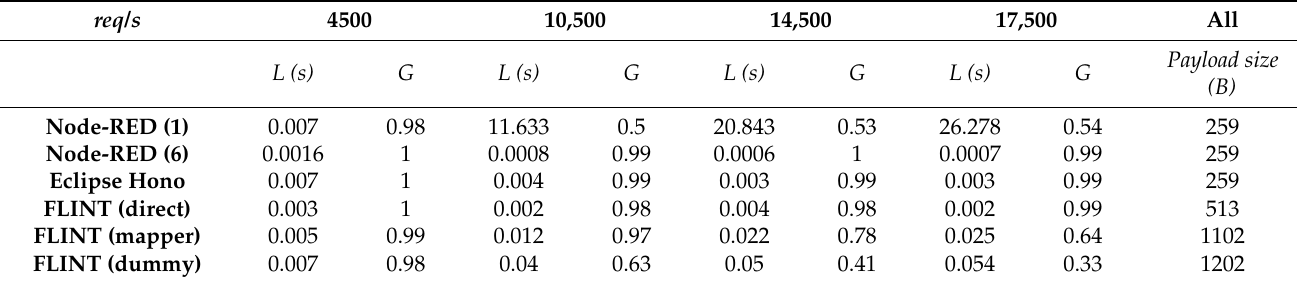
Table 2. The Latency (L) in seconds, the Goodput (G) and the Payload size in bytes for the evaluated platforms.